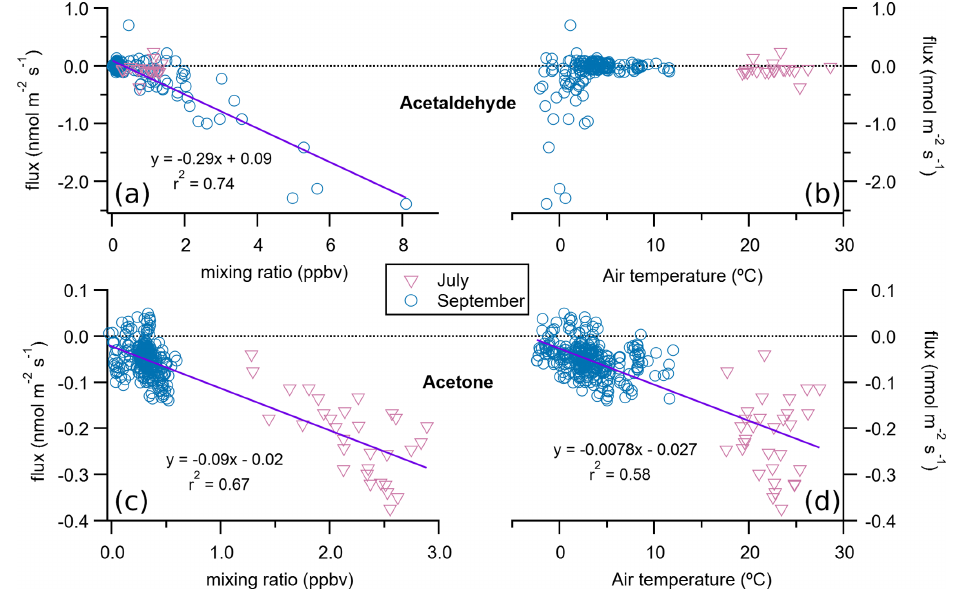
Figure 6. Relationship of lake fluxes of acetaldehyde (a, b) and acetone (c, d) with their respective atmospheric mixing ratios (a, c) and the air temperature (b, d) . Each solid line and corresponding equation represent an orthogonal distance regression to all 30min flux data points for both July and September ( n = 191 for acetaldehyde and n = 338 for